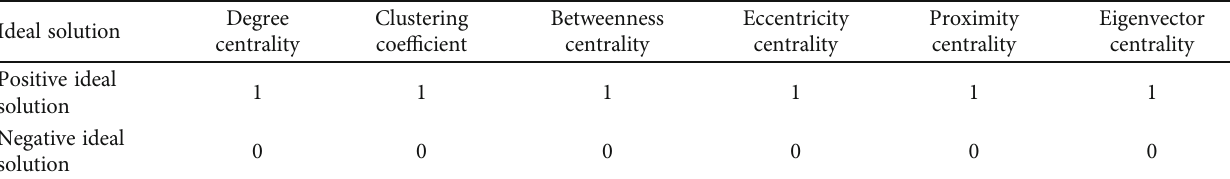
Table 15: The positive and negative ideal plan of the disc assembly